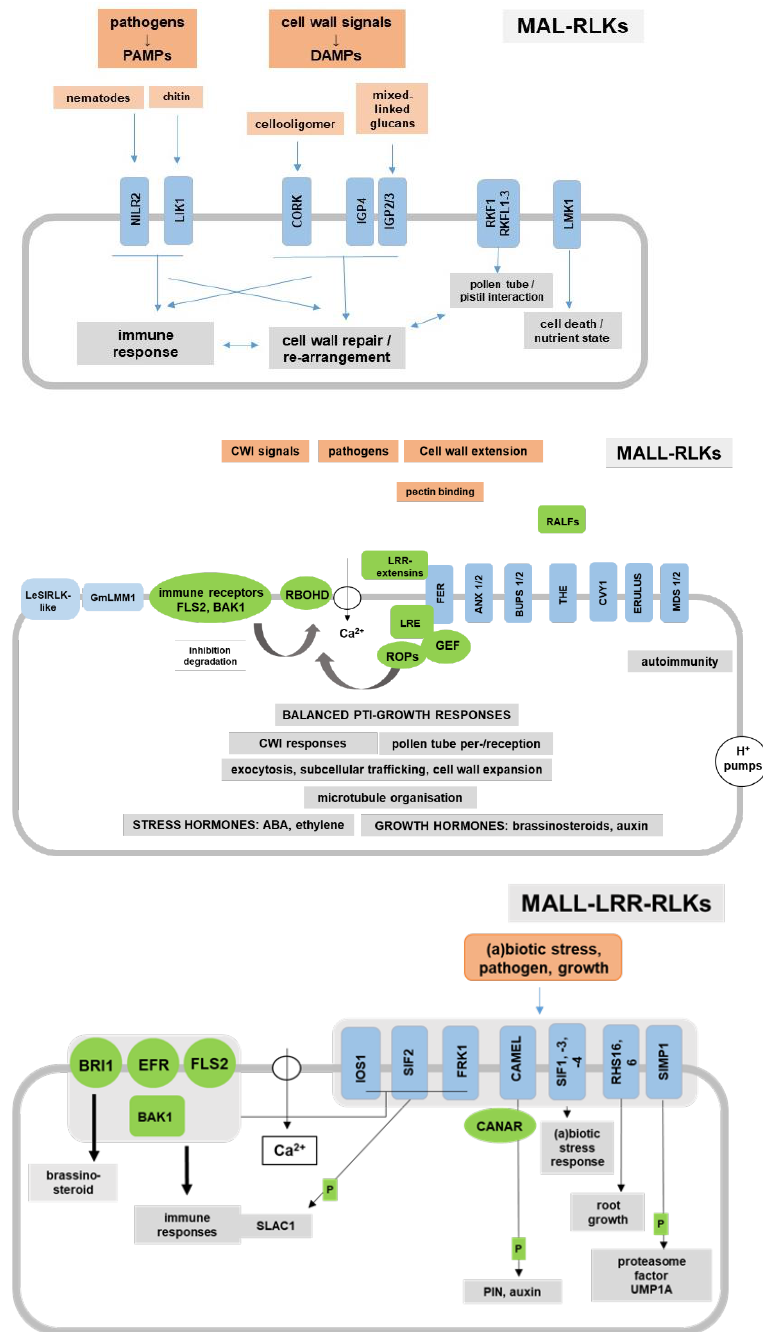
Figure 2. Activation, interaction and signaling of MAL- and MALL-RLKs. They are grouped according to their phylogenetic relationship (Figure 1) into LRR-MAL-RLKs, MALL-RLKs and MALL- LRR-RLKs. Arabidopsis MAL- and MALL-RLKs and GmLMM1 and LeSIRLK-like are in blue. They are activated by apoplastic microorganisms or signals (orange). Interaction partners and